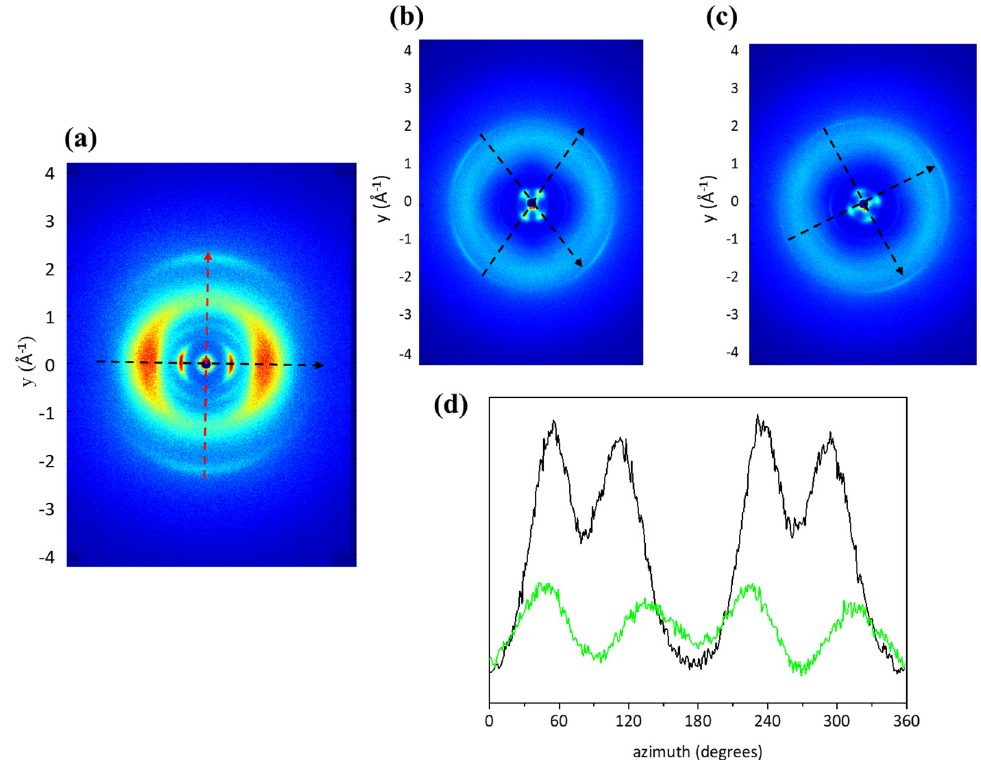
Figure 5. ( a ) A typical 2D WAXS diffraction pattern on type I collagen from animal tissue, in particular equine tendon, in which the equatorial (black arrow) and meridional (red arrow) directions are clearly distinguished. In the 2D diffraction patterns of BT ( b ) and ST ( c ), the diffraction signal is characterized by four lobes along two directions (black arrows). ( d ) The azimuthal integration along the equatorial diffraction signal of both BT (black profile) and ST (green profile) are shown.